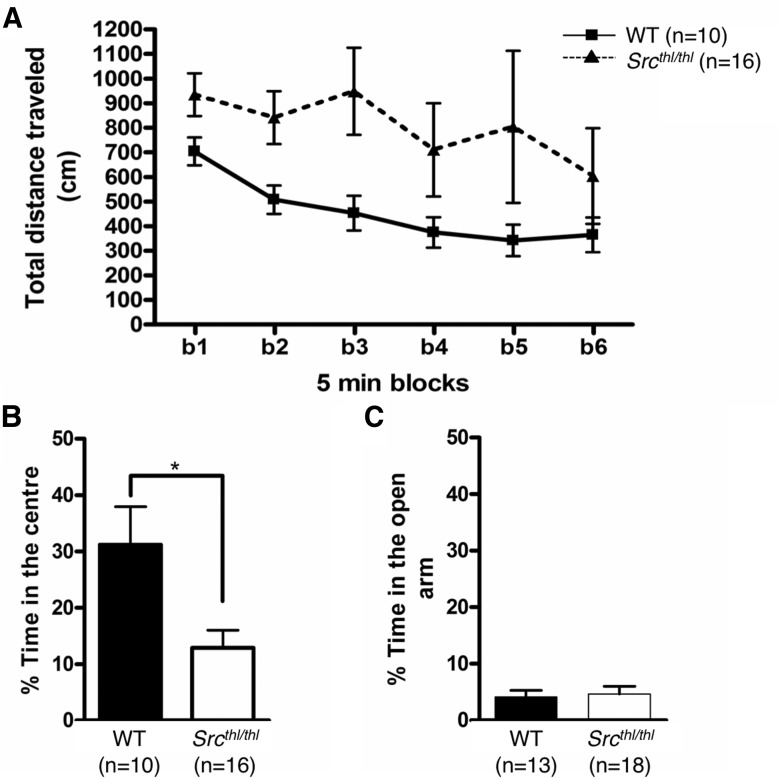
Srcthl/thl mutant mice show hyperactivity in the open field. A, Srcthl/thl mutant mice showed an increase in total distance travelled in the open field compared with WT mice (n = 10 WT (5 males, 5 females), n = 16 Srcthl/thl (9 males, 7 females)). B, Percentage of time spent in the center of the arena versus the entire open field was decreased in Srcthl/thl (n = 10 WT (5 males, 5 females), n = 16 Srcthl/thl (9 males, 7 females)). *p < 0.05 between genotypes. C, Percentage time spent in the open arms versus the closed arms of the elevated plus maze showed no significant differences between genotypes (n = 13 WT (7 males, 6 females), n = 18 Srcthl/thl (9 males, 9 females)). Data are presented as mean ± SEM.